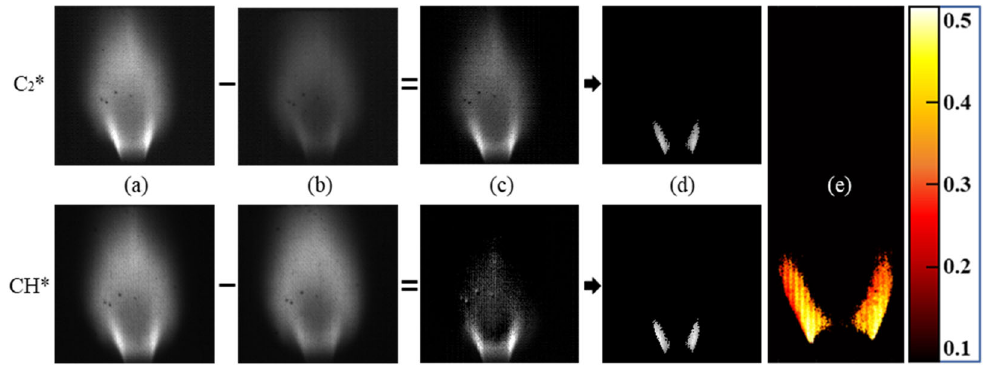
Figure 5. Four-line image processing method. ( a ) Average species signal, ( b ) average broadband signal, ( c ) subtracted signals, ( d ) thresholded flame structure, and ( e ) C 2 */CH* intensity ratio.